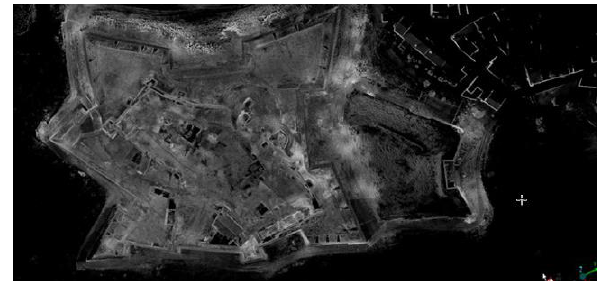
Figure 3. TLS point cloud model.